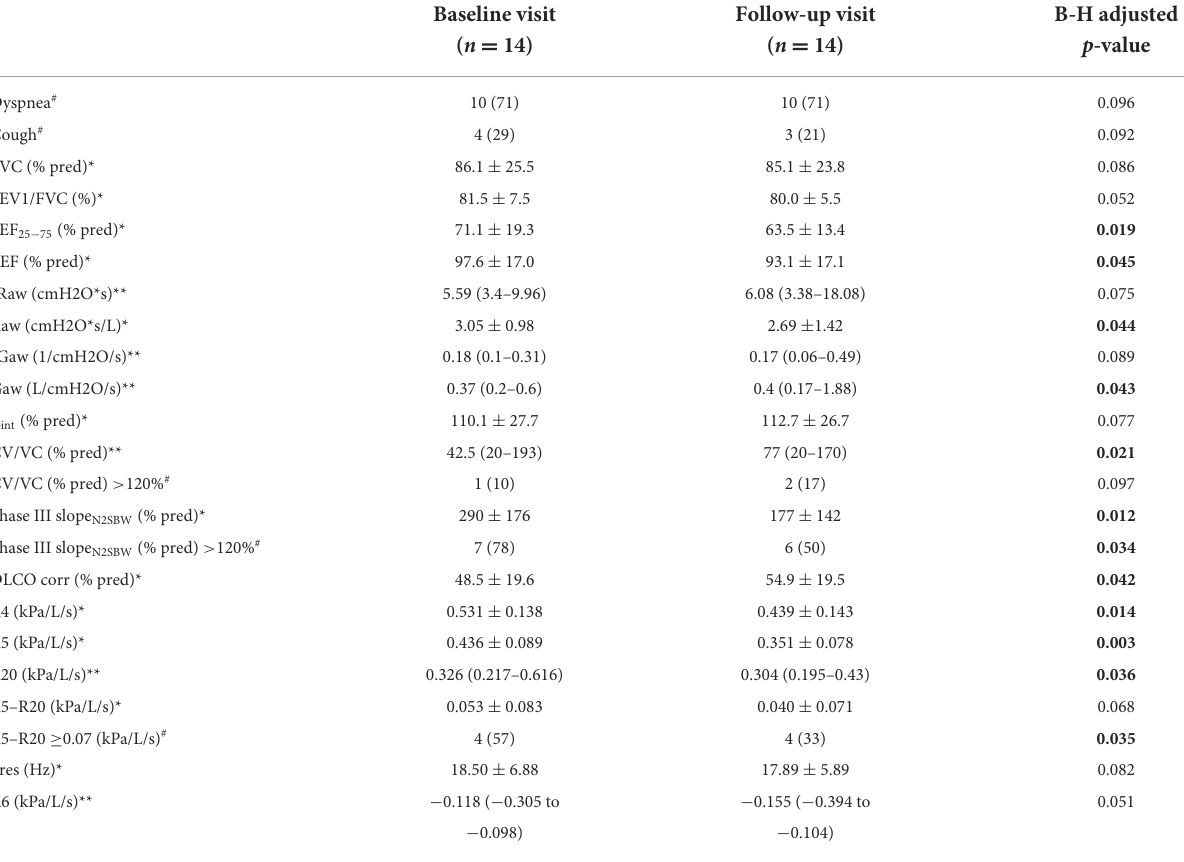
TABLE 5 Comparison of pulmonary and small airway parameters of 14 SSc-ILD patients between baseline and follow-up visit.